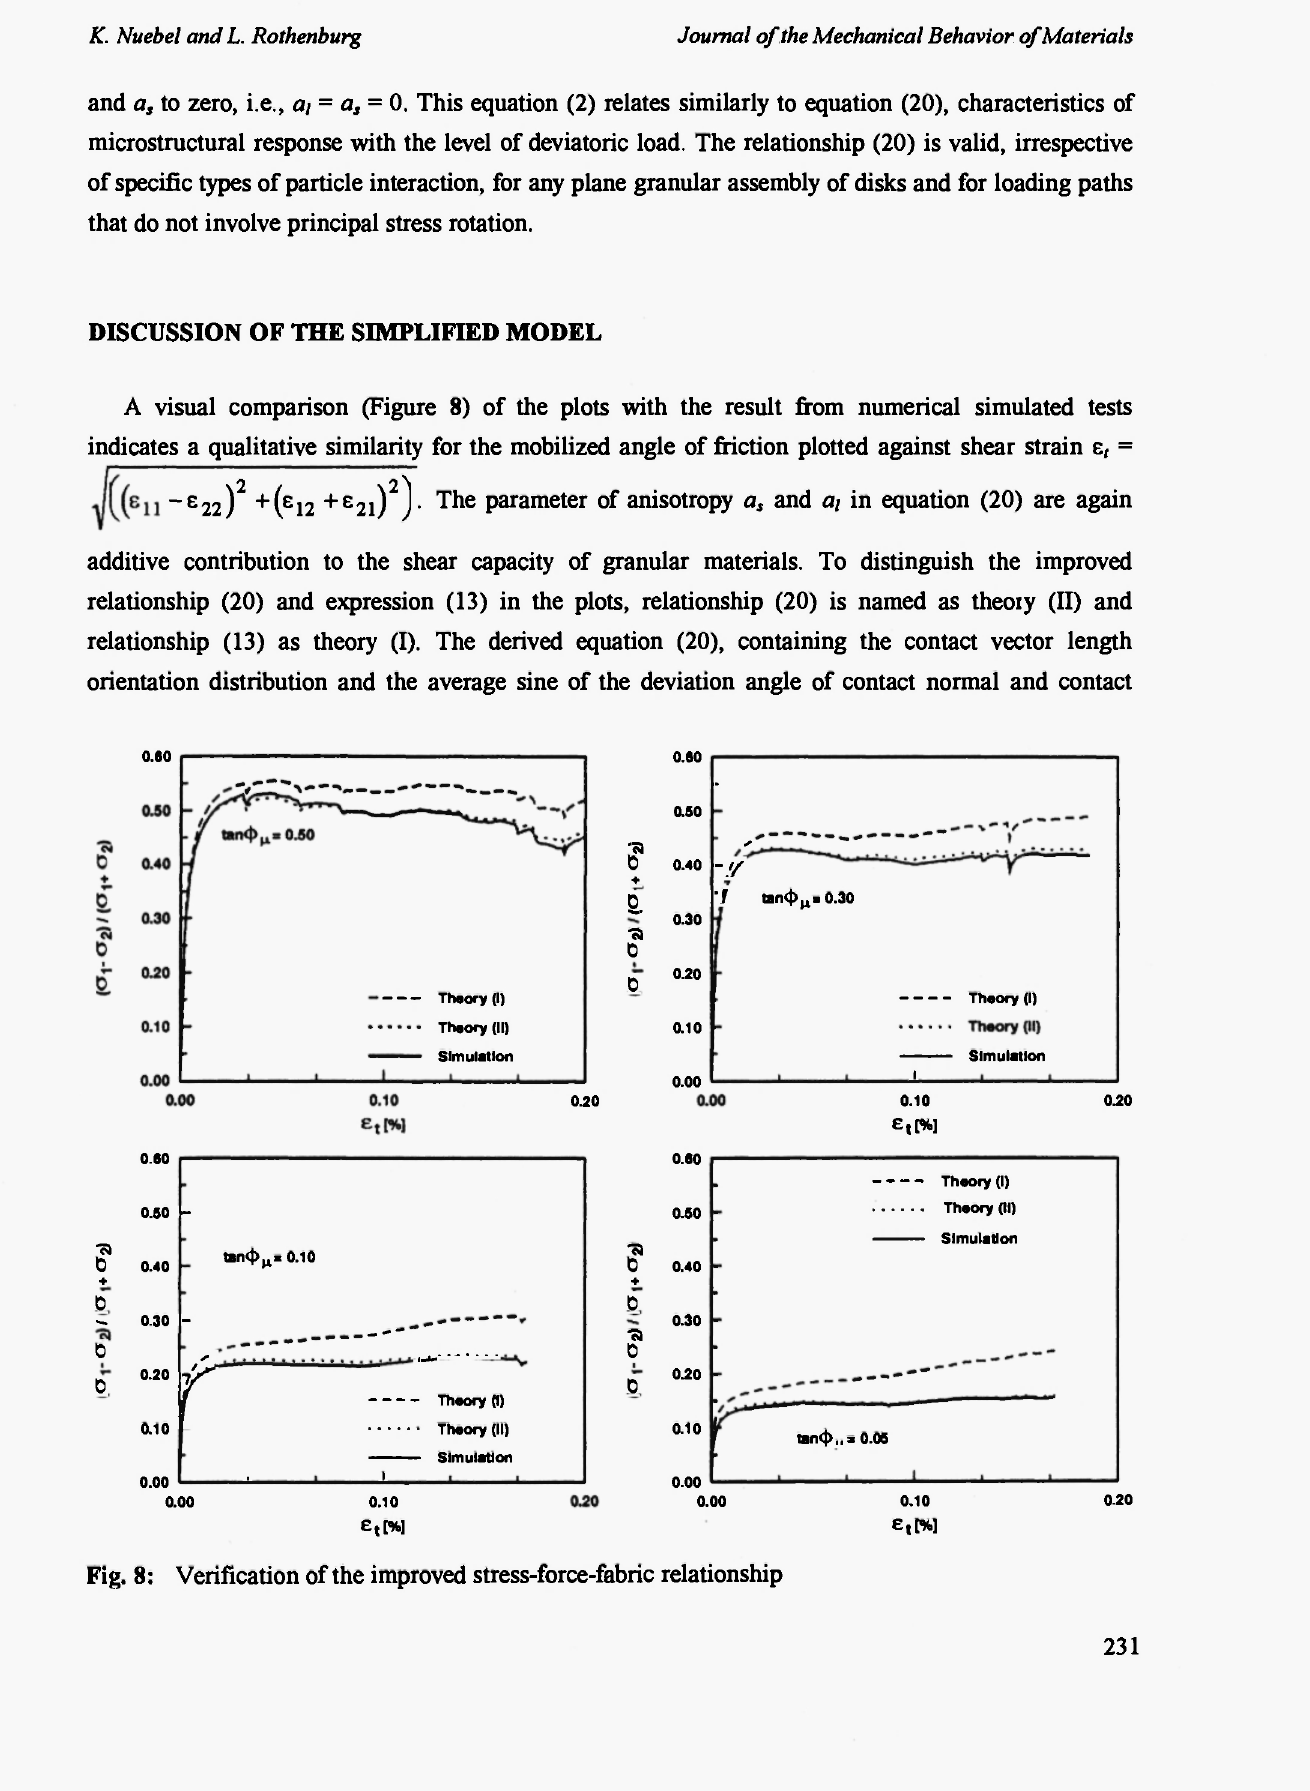
Fig. 8: Verification of the improved stress-force-fabric